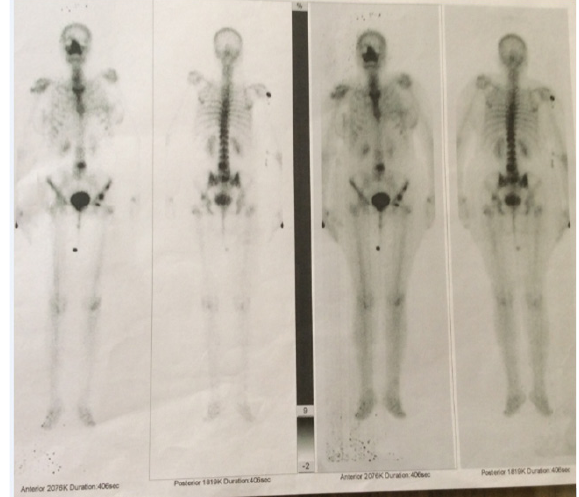
Figure 1: Metastatic breast cancer with extensive bony metastases involving most dorsal and lumber vertebrae, ribs bilaterally pelvic bones and both femora